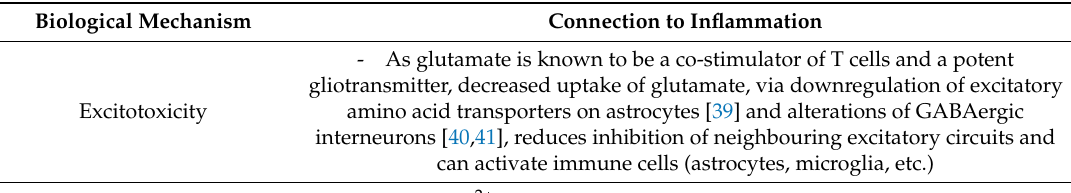
Table 2. Overview of secondary mechanisms of injury and their connection to